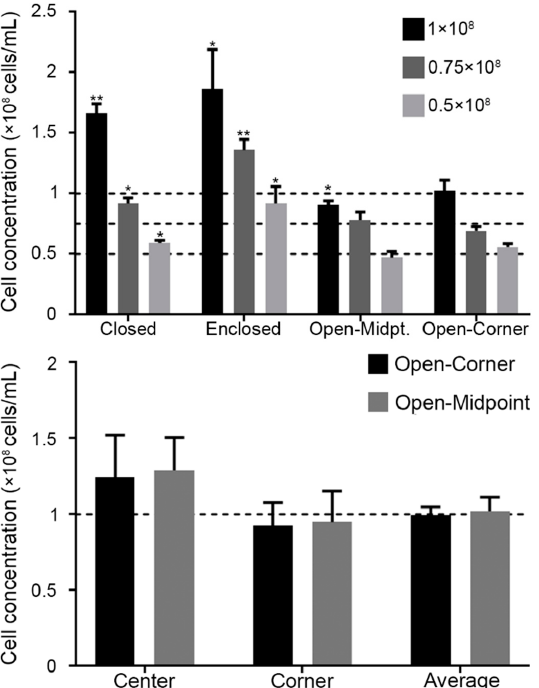
Figure 3. Comparison of four different designs for cell counts of serial dilutions of goldfish sperm at 1 × 10 8 , 0.75 × 10 8 , and 0.5 × 10 8 cells/mL ( n = 5; mean ± SEM) with one-sample t -test using the serial dilution concentrations as the hypothetical mean ( top ). Comparison of open-midpoint and open-corner designs for counting of zebrafish sperm (1 × 10 8 cells/mL) ( bottom ) ( n = 3) with two-way ANOVA for multiple comparisons (Dunnet), compared to Average * indicates P < 0.05 and ** indicate P < 0.01. The dashed line indicates solution concentrations.